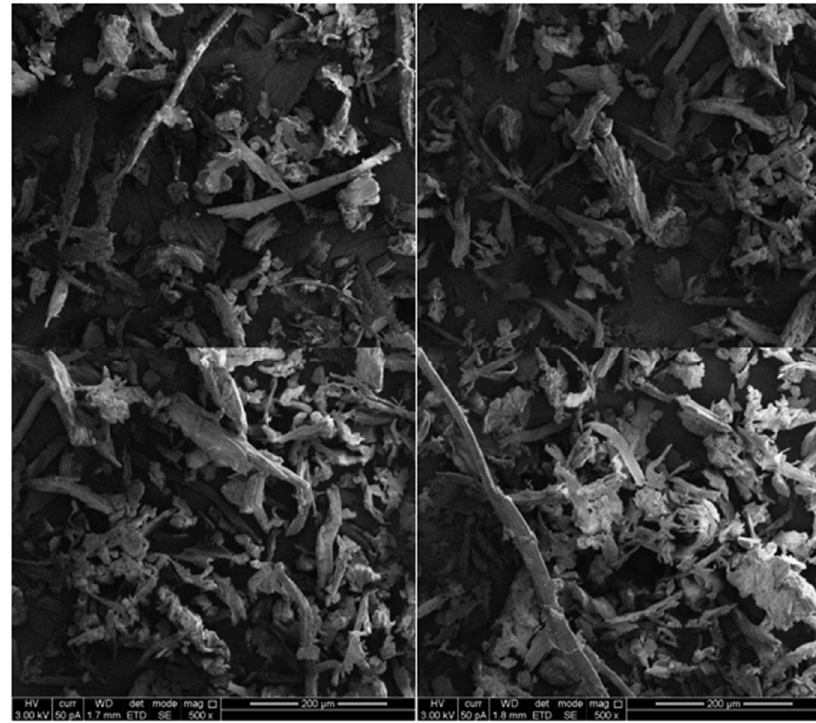
Figure A1. Wood flour particles in the powder starting material. Figure A1. wood flour particles in the powder starting material. Figure A1. wood flour particles in the powder starting material.